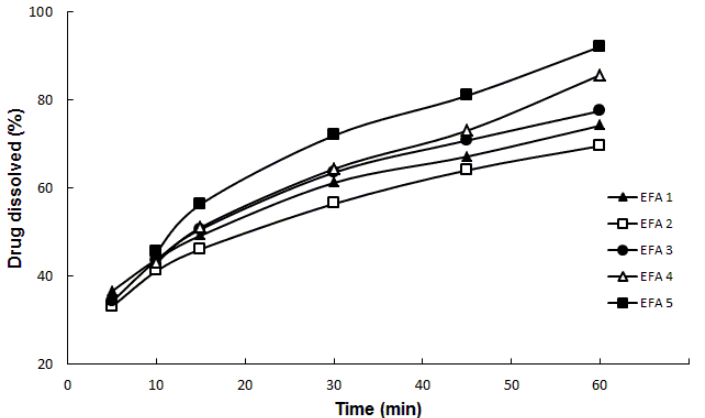
Figure 2 . Results of dissolution by dispersion of efavirenz batches 1 to 5 (EFA 1 to